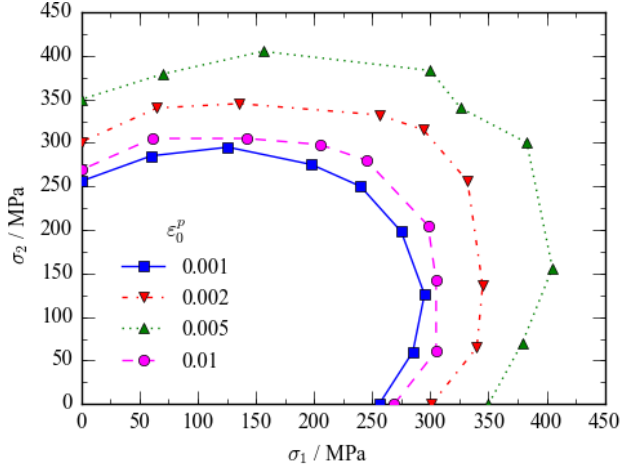
Figure 18. Q235 steel sheet yield surface.